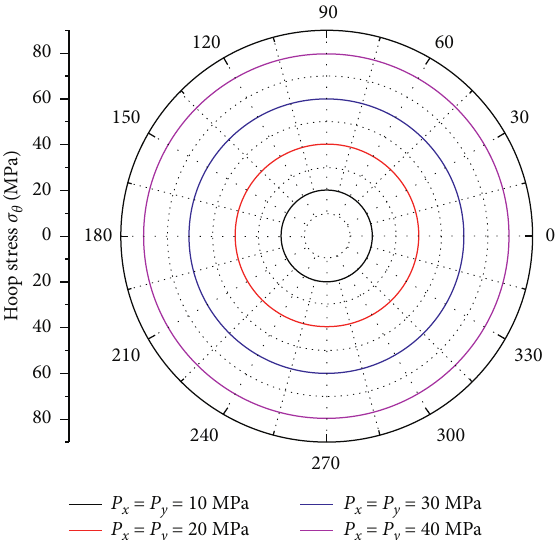
Figure 12: Hoop stress distributions along the edge of the borehole under different values of P